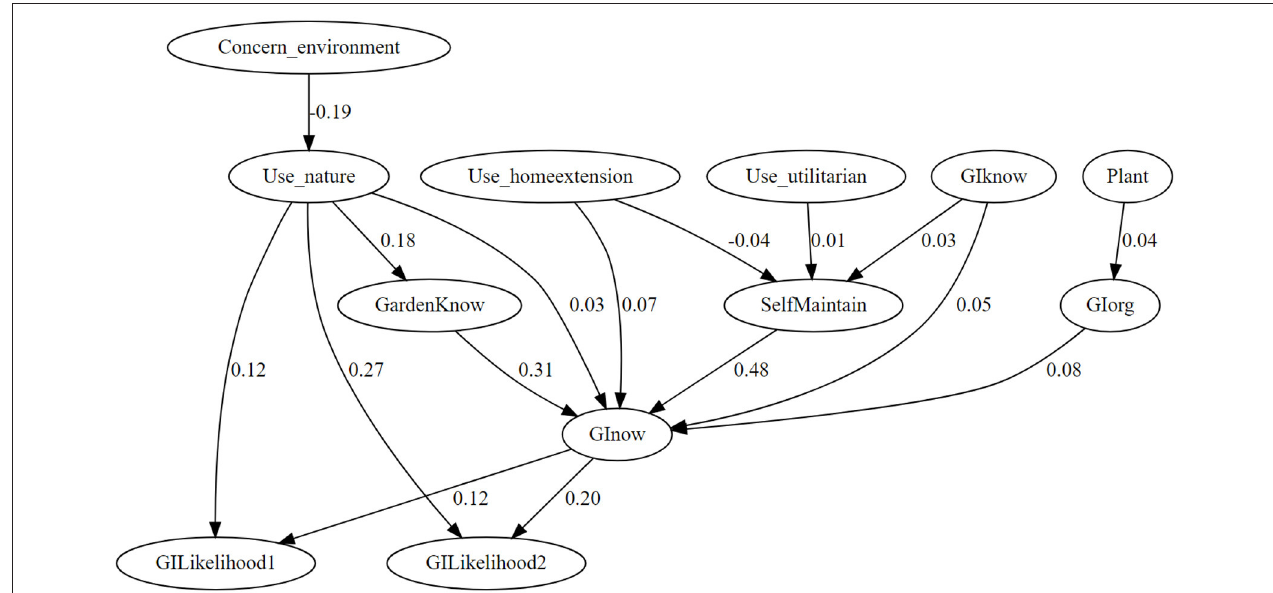
FIGURE 2 | Structural equation model analysis results assessing the influence of concerns (i.e., Concern_environment), knowledge of gardening (GardenKnow) and knowledge of GI (GIKnow), level of awareness of and engagement with local GI initiatives (GIorg), uses of outdoor space (i.e., Use_homextension, Use_utilitarian, Use_nature), level of self-maintenance of outdoor space (SelfMaintain), experience planting vegetation (Plant), and previously installed GI features (GInow), on likelihood to install additional GI features on residential outdoor space (GILikelihood1, which describes intention to install gardening features; GILikelihood2, which describes intention to install trees and shrubs). All paths are statistically significant ( p < 0.05) and numbers represent the standardized regression coefficients ( N = 533). The model was adjusted for socio-demographics, including age ( > 60years), gender (female), education (university degree), ethnicity (White), income ( > $75,000), born in Canada, years of residence in current home ( > 20 years), years of residence in Canada if not Canadian born ( > 20 years), and having children in the home. However, for simplicity, socio-demographic variables are included in the